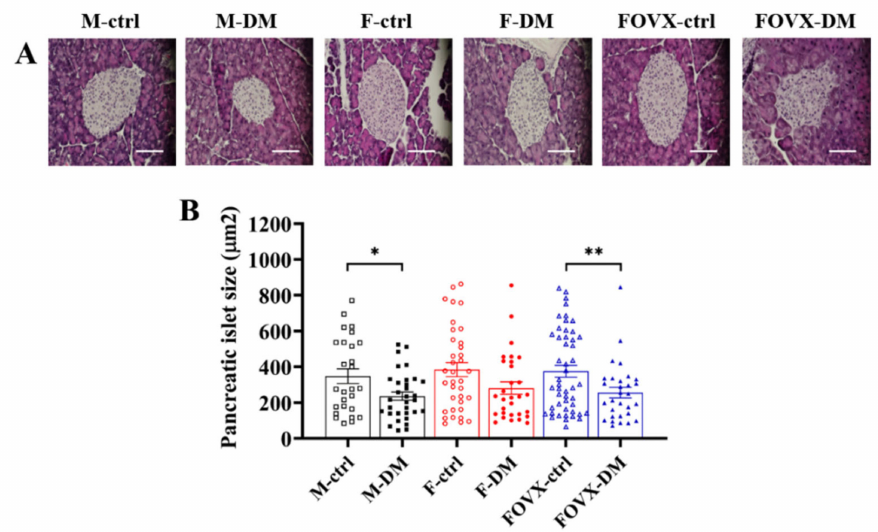
Figure 3. Pancreatic islets’ size at week 6 after STZ treatment. Hematoxylin and eosin staining ( A ) and mean value of pancreatic islets ( B ) in all groups. The size of pancreatic islets was significantly decreased in the M-DM and FOVX-DM mice compared with the control mice. Data were analyzed using an independent two-sample t -test. * p < 0.05, ** p < 0.01 compared with the respective control